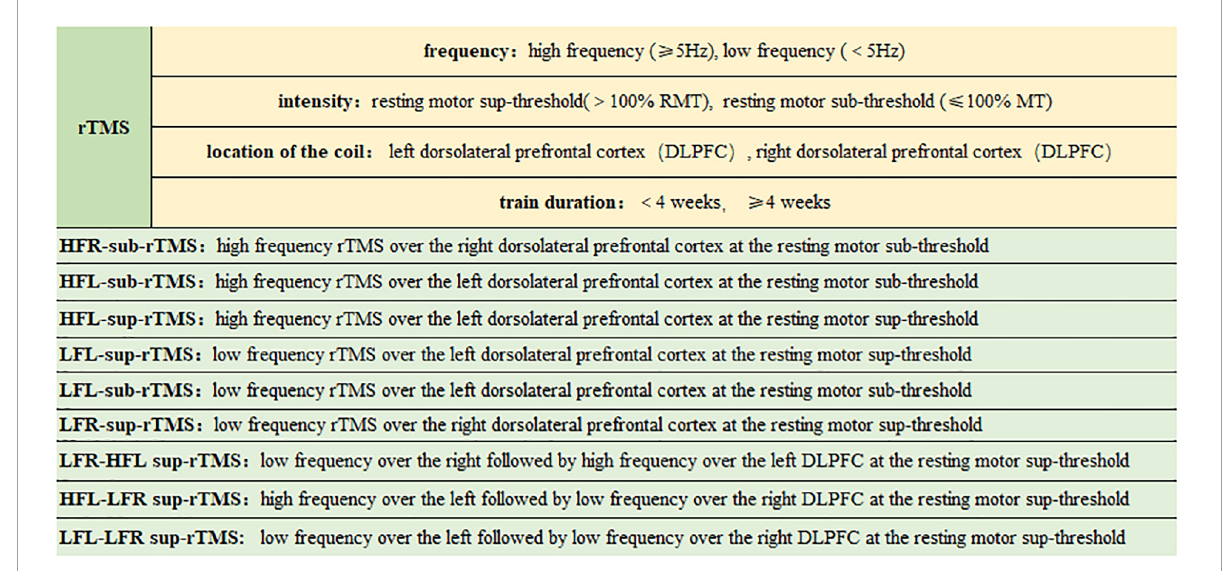
FIGURE1 The classification of rTMS interventions analyzed in this